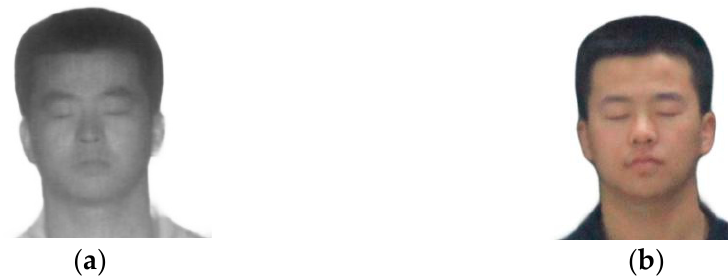
Figure 2. Data preprocessing results. ( a ) Laser face image. ( b ) Visible face image.